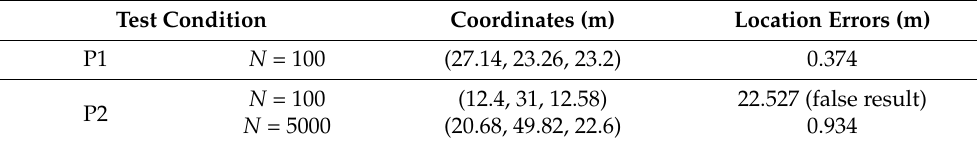
Table 2. Location results using the proposed algorithm for measurement points P1 and